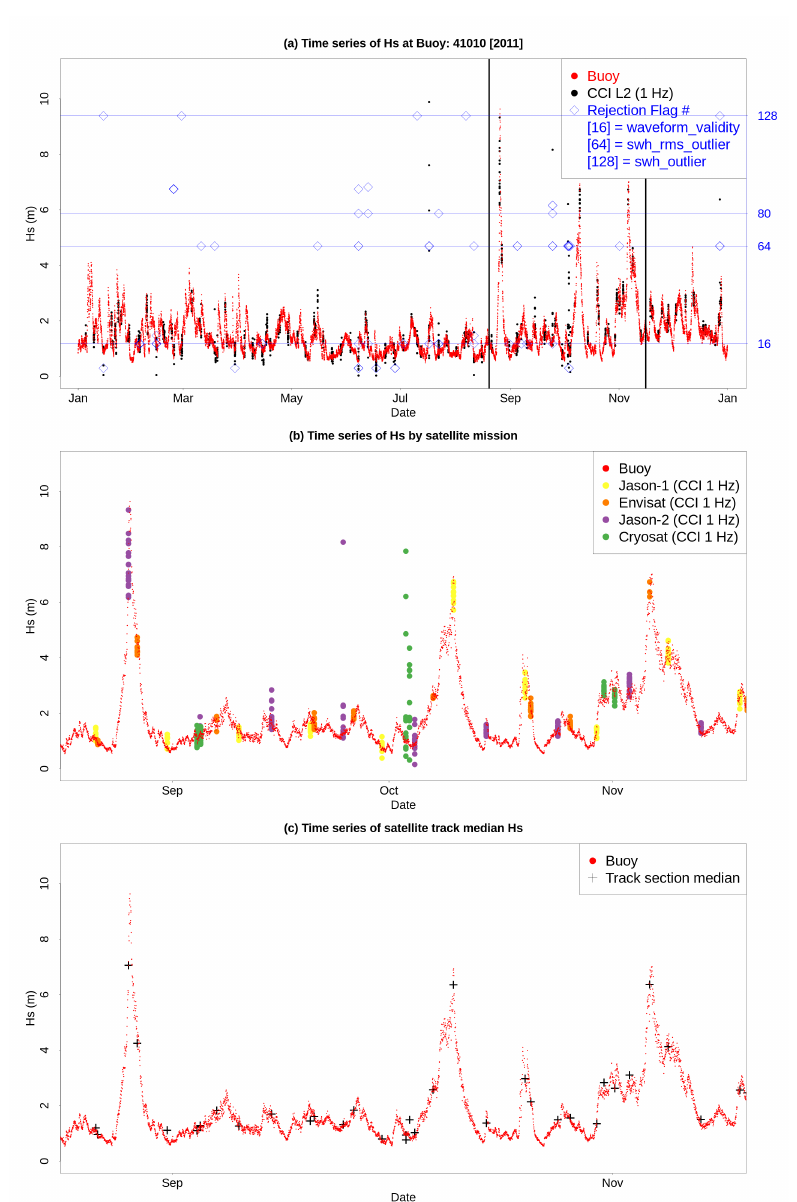
Figure 7. A comparison of measurements of Hs from buoy 41010 and satellite, based upon a 50 km sampling radius. Data with all quality flags (qual_flag = [1,2,3]) is shown in ( a , b ). ( a ) shows the time series from the buoy overlaid by the complete 1 Hz record from the Sea State CCI L2P product. Selected rejection flags are indicated by blue diamonds with values on the right-hand axis. Blue horizontal lines correspond to the right-hand axis and denote the rejection values more clearly. ( b ) is an enlargement of a section of ( a ) indicated by vertical black lines, and shows the same data but coloured by mission. ( c ) is similar to ( b ) but shows the median value (black crosses) of each track segment for 1 Hz measurements where qual_flag = 3